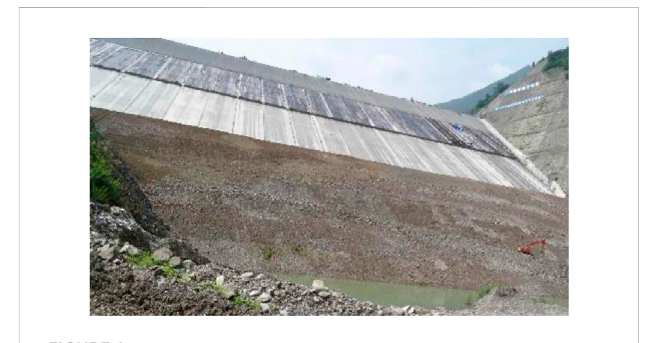
FIGURE 1 The construction of concrete face rock fi ll